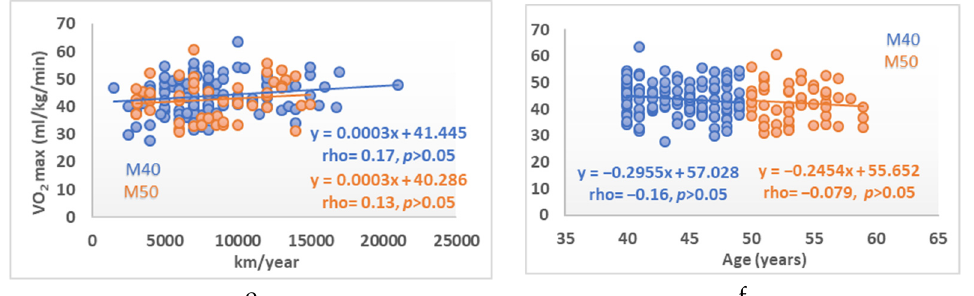
Figure 3. Relationship between cardiorespiratory fitness variables (Peak power output (W and W/kg) and VO 2 max) and km/year cycled ( left column) and age ( right column). ( a ) Peak power output versus cycling kilometers, ( b ) Peak power output versus age, ( c ) Peak power output relative to body weigh versus cycling kilometers, ( d ) Peak power output relative to body weight versus age ( e ) Maximal oxygen uptake versus cycling kilometers, ( f ) Maximal oxygen uptake versus age